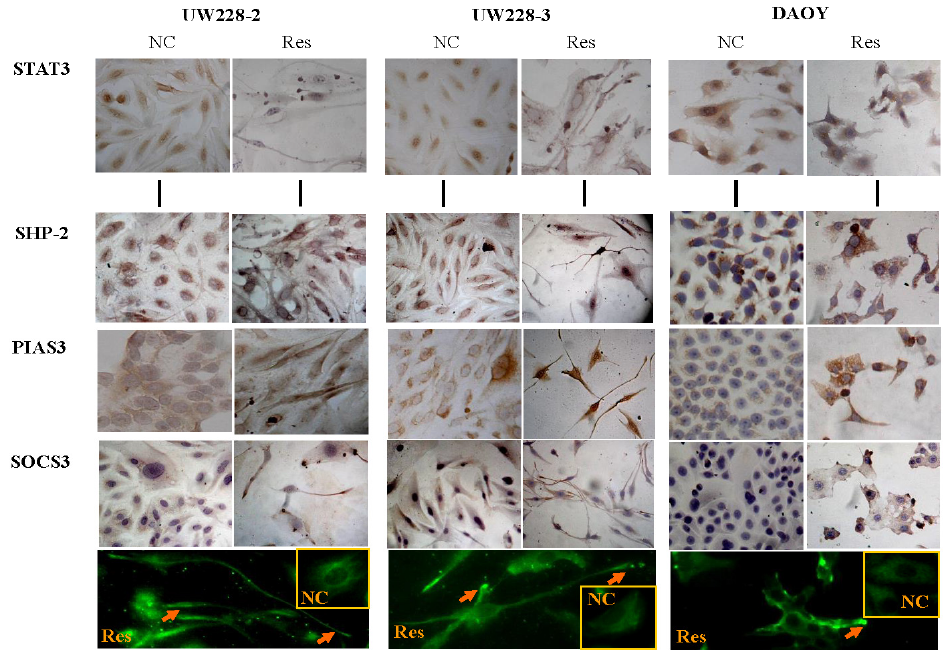
Figure 4. Immunocytochemical demonstration of STAT3, p ‐ SHP2, SOCS3 and PIAS3 expression in three human medulloblastoma cell lines without (NC) and with 100 μ M resveratrol treatment (Res) for 48 h (20×). Arrows in the immunofluorescent images (40×) indicate SOCS3 accumulation in the distal end of the axon ‐ like processes of the three resveratrol ‐ treated medulloblastoma cell lines. The inset images are the normally cultured cells.